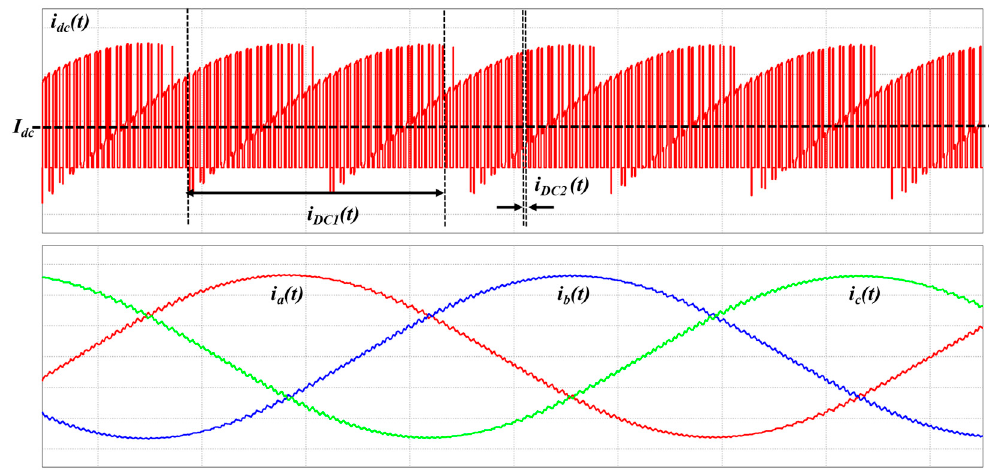
Figure 6. Analysis of the DC-link current ripple.